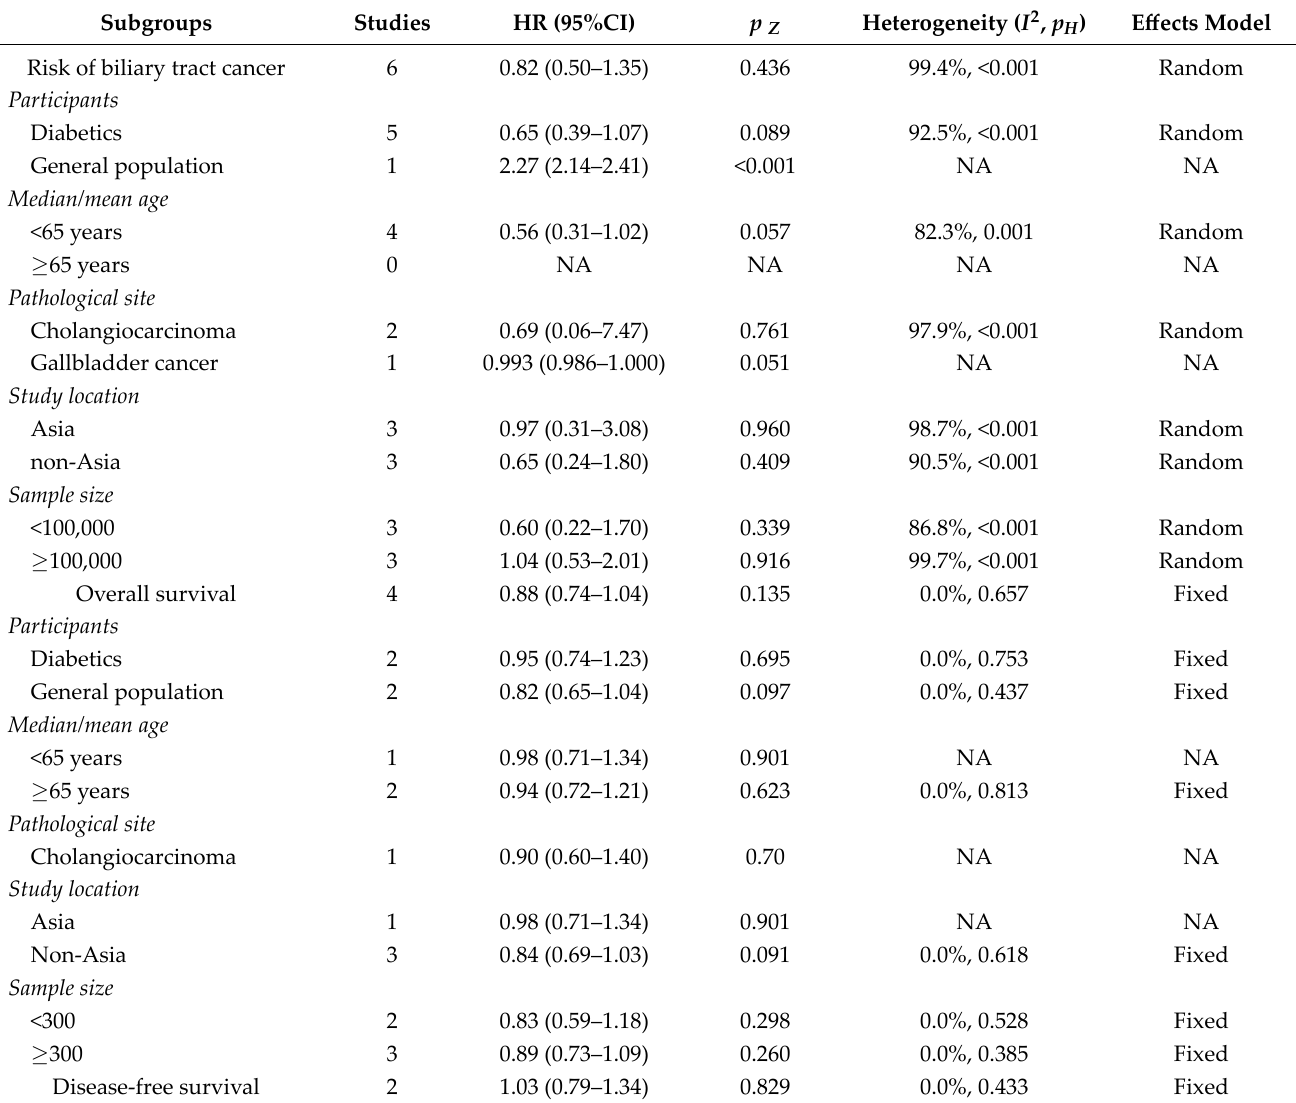
Table 3. Stratified analysis of the association between metformin and the risk and prognosis of biliary tract